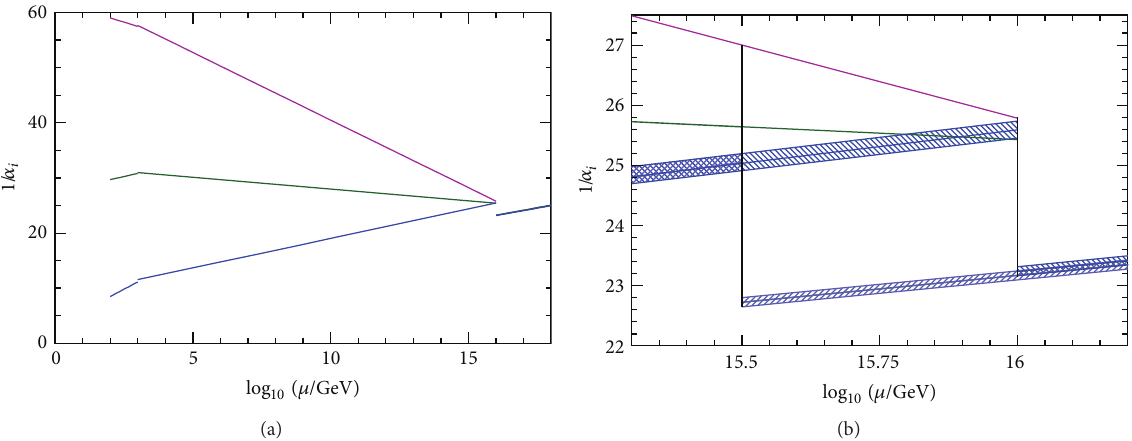
and 𝜇 = 𝜇 SUSY GUT is shown where for the decoupling the two values GUT